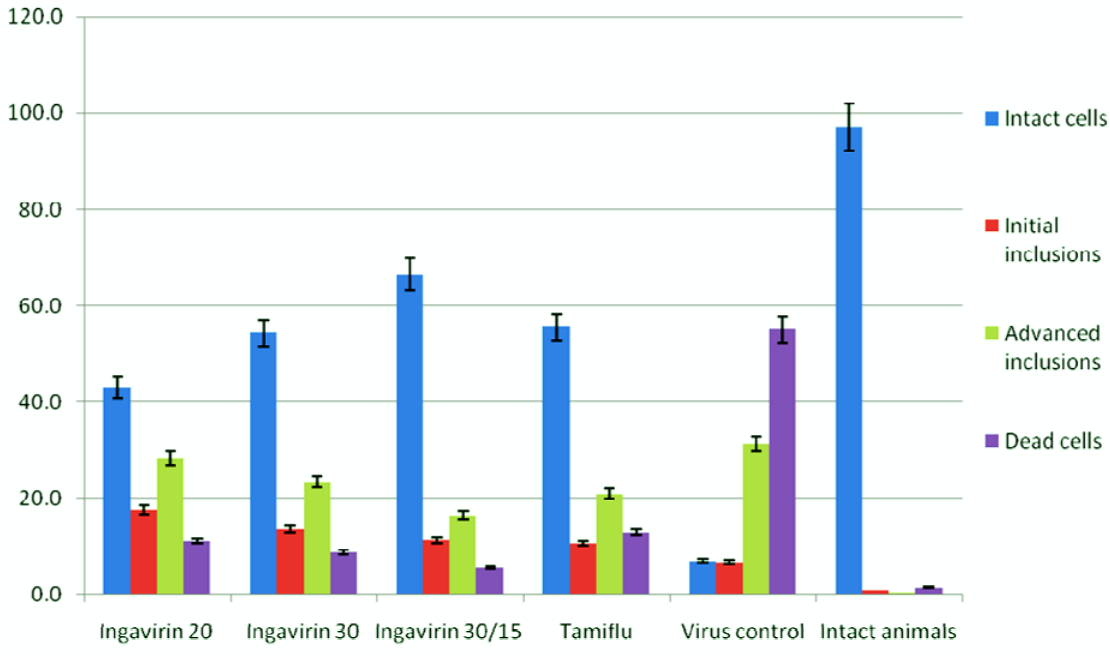
Figure 4. Cytoprotective activity of Ingavirin in cells of bronchial epithelium after infecting with mouse-adapted influenza virus A/California/7/09 (H1N1)v (day 3